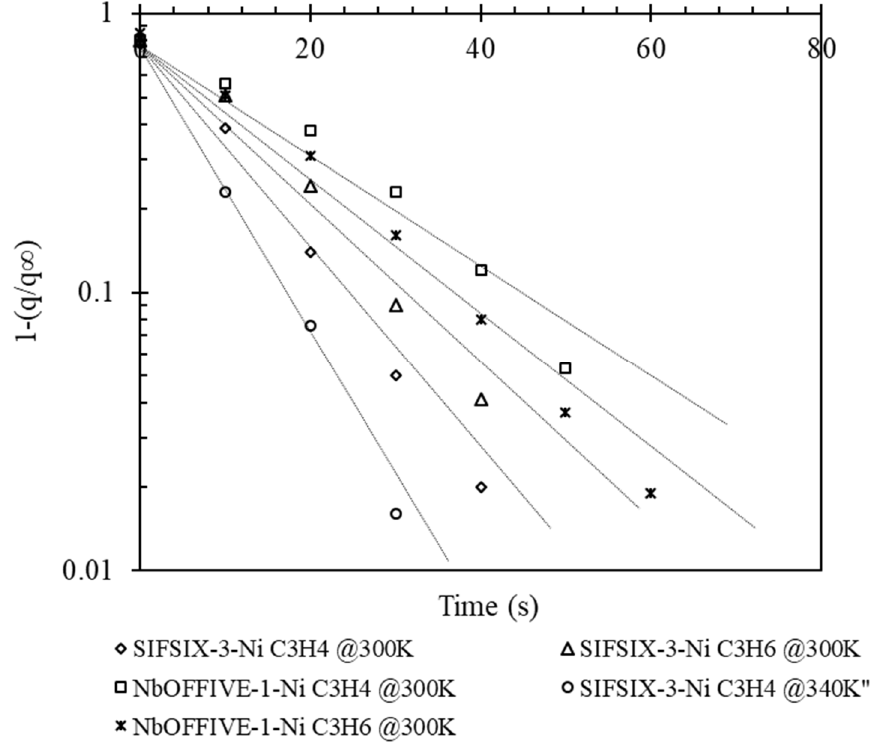
Figure 7. Fractional adsorption rate for C 3 H 4 /C 3 H 6 on SIFSIX-3-Ni and NbOFFIVE-1-Ni.